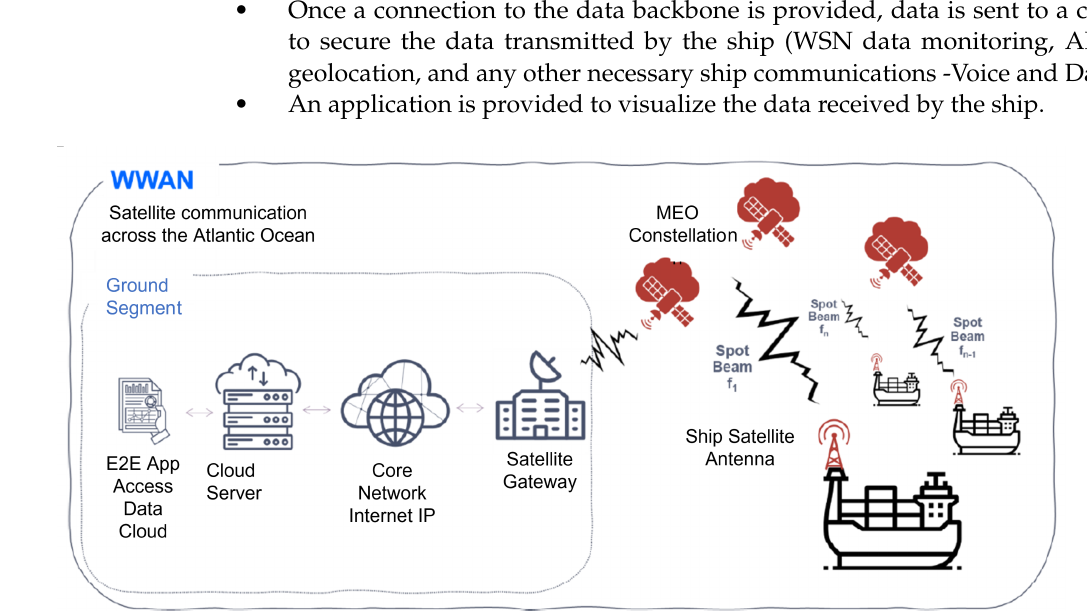
Figure 5. WWAN subsystem scheme.